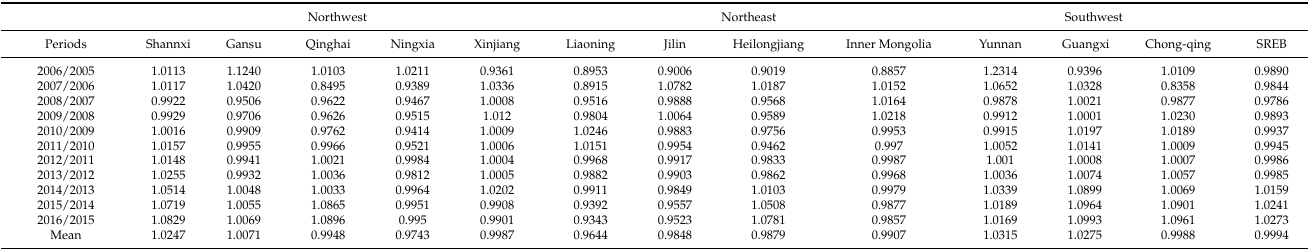
Figure 4. Change trend of CRP for the SREB and each province. Table 4. Technical-efficiency performance by provinces along the SREB. Northwest